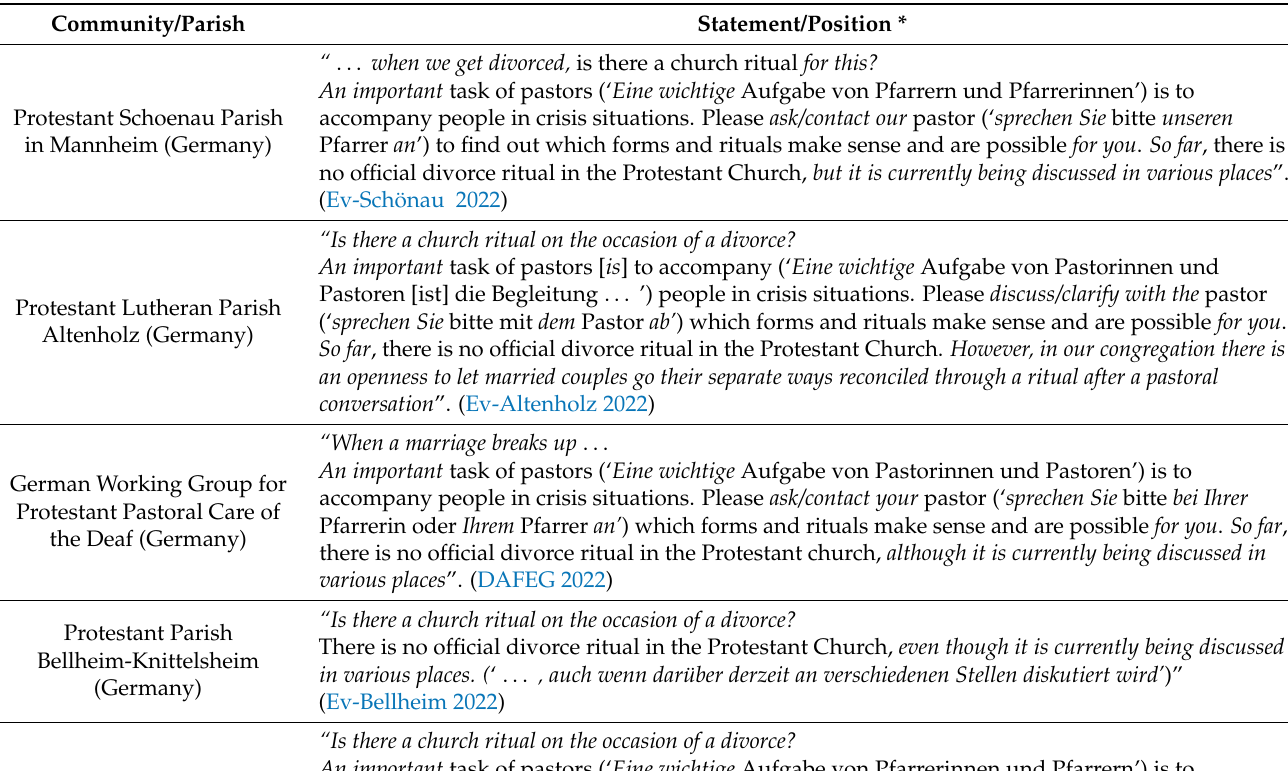
Table 1. Statements on divorce rituals from official local church/parish websites.